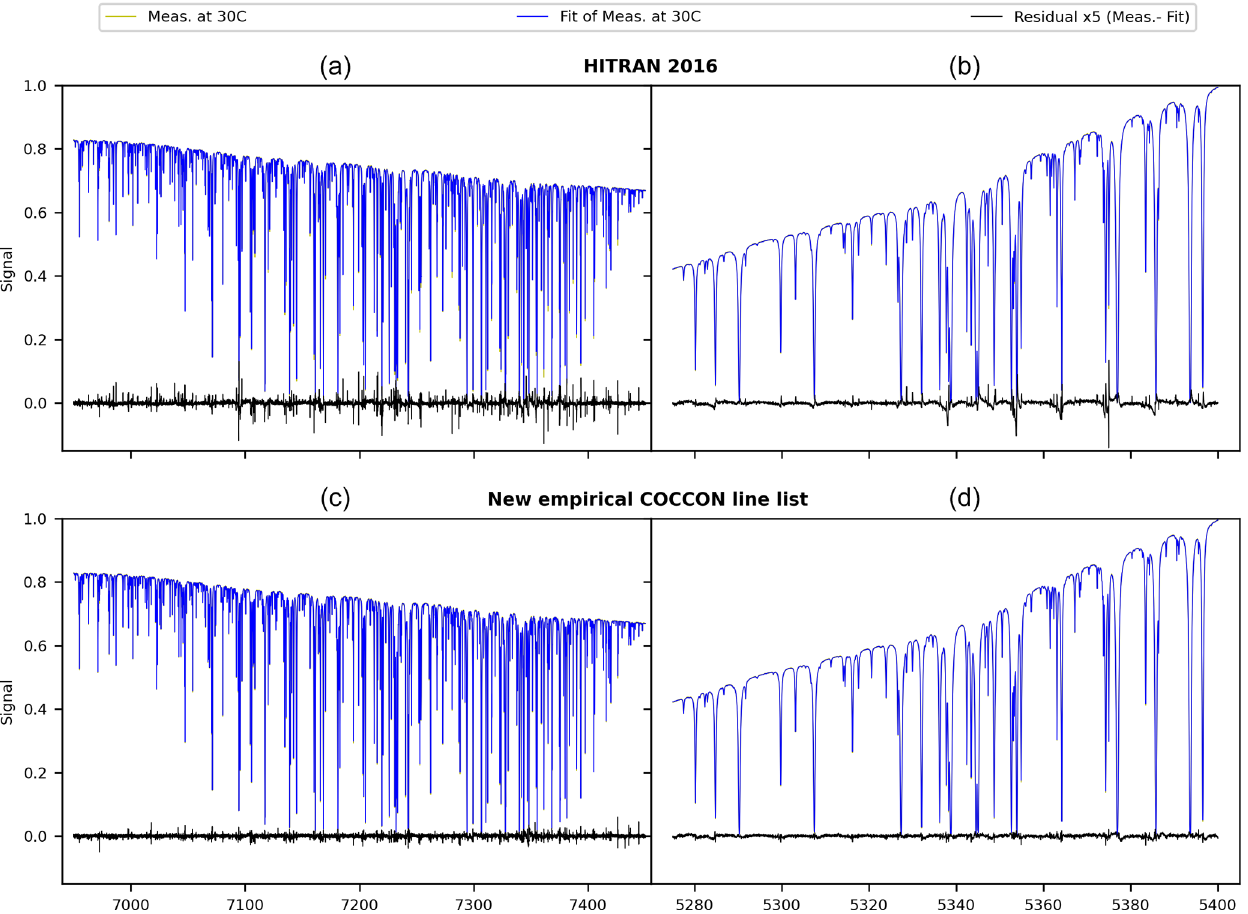
Figure A2. Same as Fig. A1, but the measured spectra were taken with the IFS125HR at KIT Karlsruhe, at 30 ◦ C.